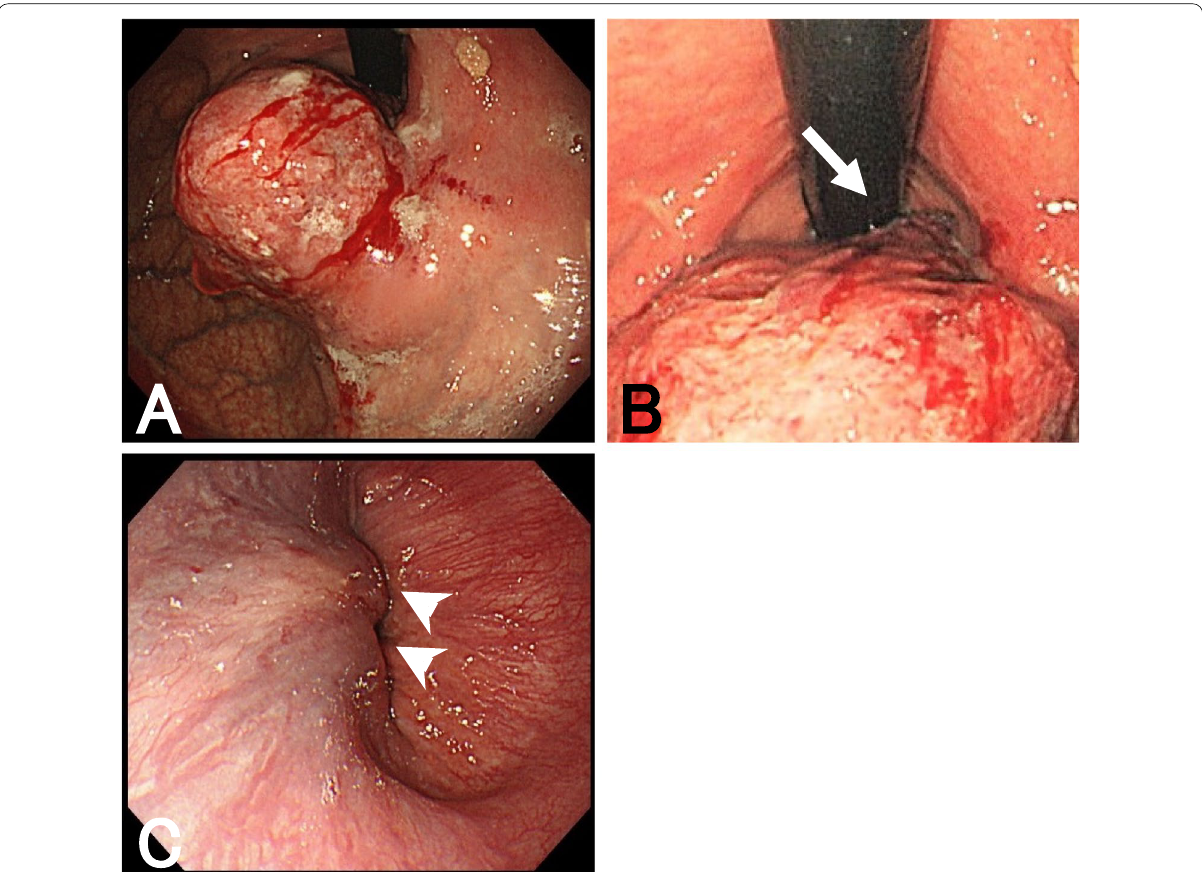
Fig. 1 Esophagogastroduodenoscopy findings. A An elevated lesion is found in the EGJ. The tumor is easy to bleed, and its demarcation is ill-defined because of submucosal invasion. B The tumor overhangs in the gastric cardia, but continues into the squamocolumnar junction (arrow). C In the lower esophagus, the tumor invades in the esophageal submucosa (arrowheads). The lumen of the EGJ is